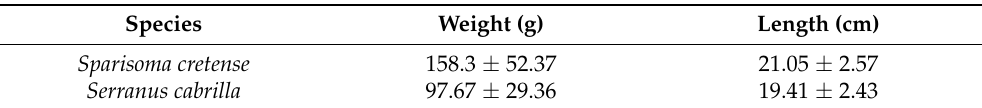
Table 1. Biometric means of the study species.